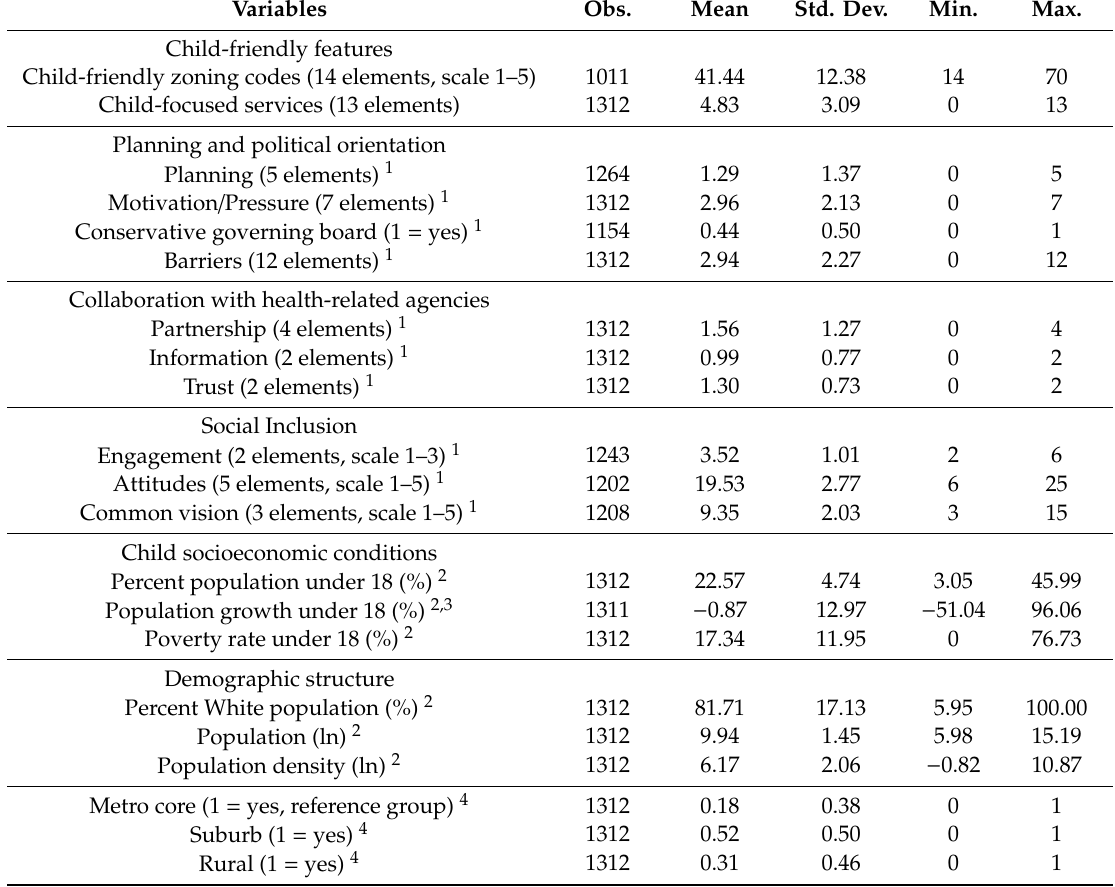
Table 3. Planning Healthy Places for Children: descriptive statistics.